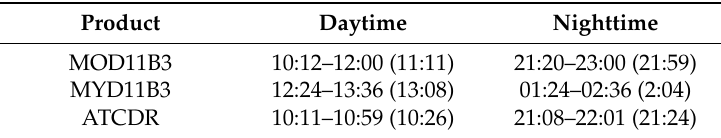
Table 2. Local time interval (and average local time) of acquisition of satellite images after considering all the images and pixels of the study